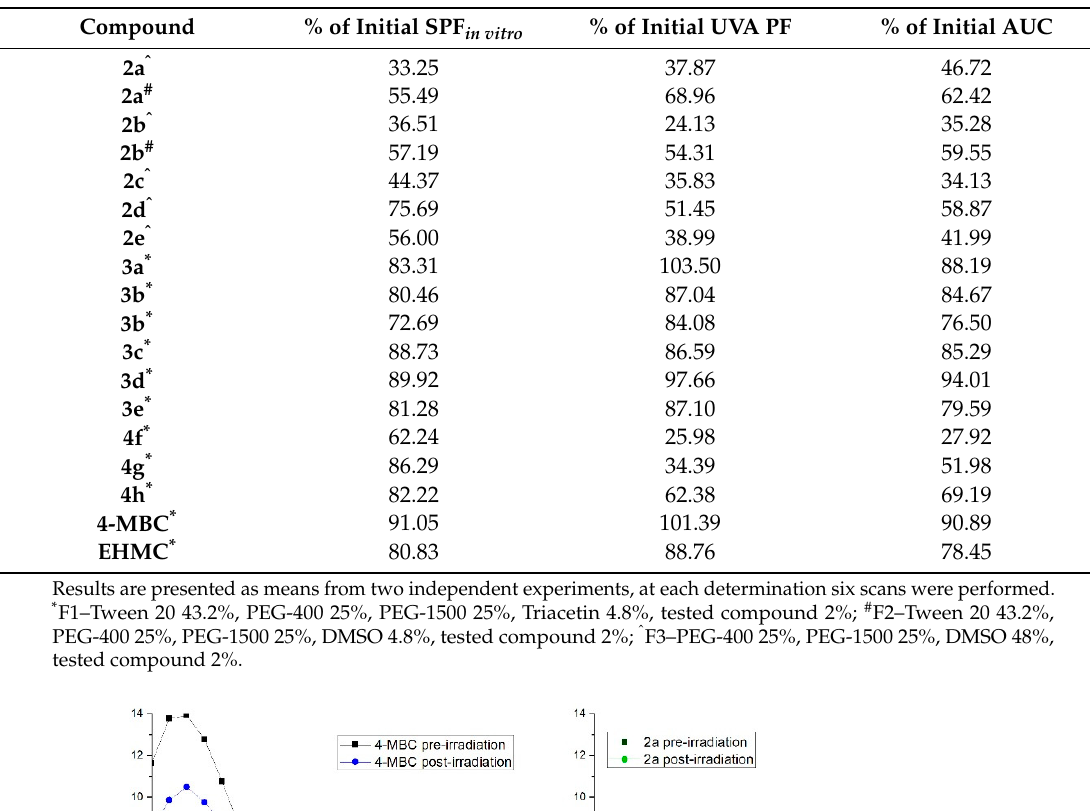
Table 3. The changes in photoprotective activity of tested compounds and reference UV-filters after irradiation with solar light simulator at 500 W / m 2 . In the experiments appropriate formulations (F1 * , F2 # , F3 ˆ ) were used.